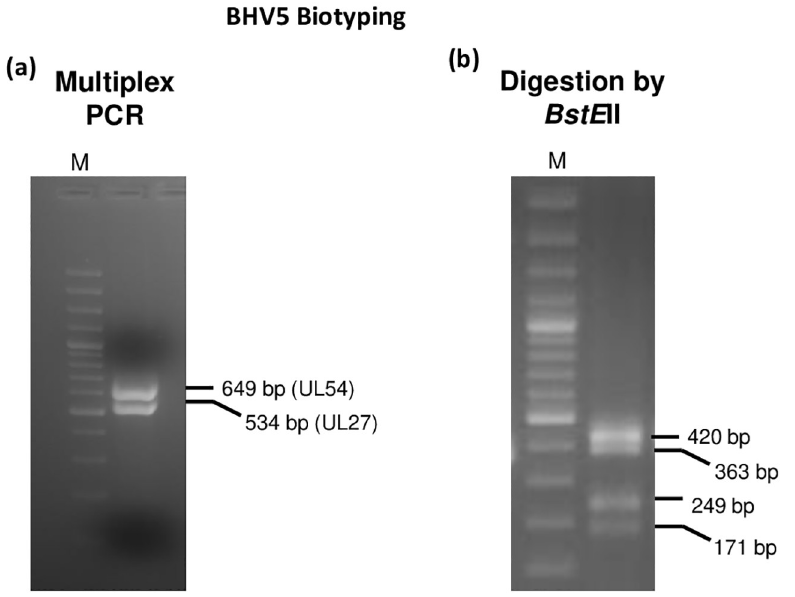
Fig 2. BoHV5 subtyping. (a) Amplification of UL27 and UL54 genes of BoHV5 by multiplex PCR resulted in amplification of 534 bp and 649 bp fragments respectively. (b) Digestion of PCR products (multiplex- UL27 and UL54 genes) by BstE II resulted in amplification of 420 bp, 363 bp, 249 bp and 171 bp